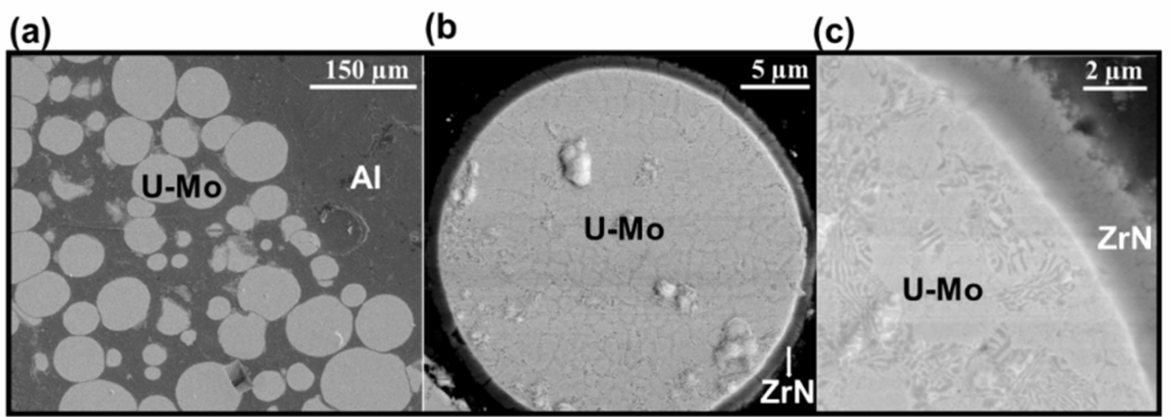
Figure 1. SEM images at different magnification of ( a ) as-fabricated U-7 wt.% Mo particles dispersed in Al matrix coated with ZrN, shown with dotted lines in ( b , c ).